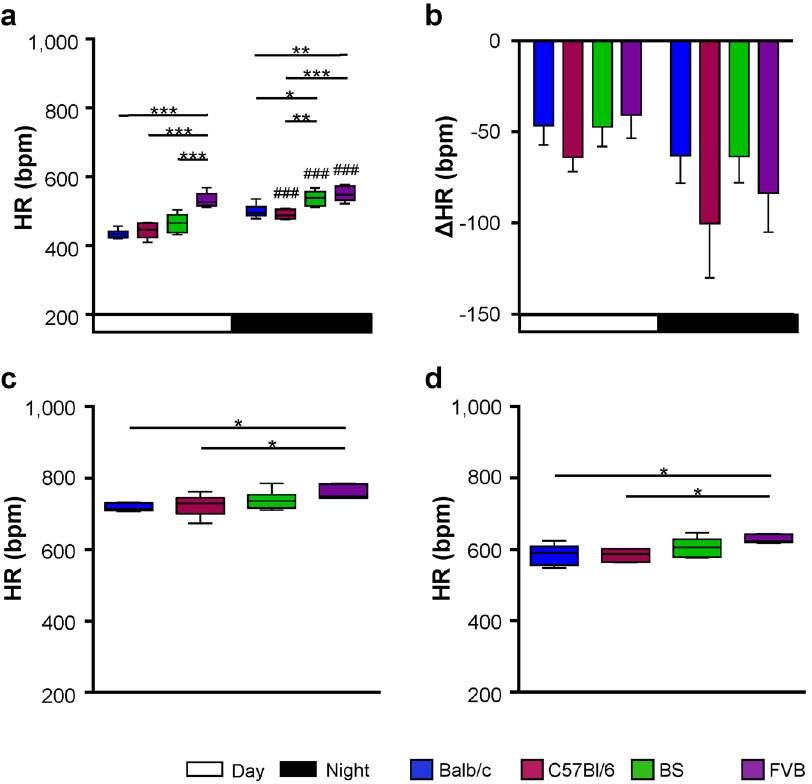
Figure 5. Heart rate under β -adrenergic modulation. ( a ) HRs under treatment with metoprolol during day- and night-time derived from 96 hours ECG recordings shown in Fig. 4. ( b ) HR reduction ( Δ HR) calculated as the difference between mean HRs under baseline conditions and under β -adrenergic blockade. ( c ) Maximal HRs and ( d ) mean HRs over 5 hours following isoproterenol injection. Day: 7AM-7PM, Night: 7PM-7AM. Data is given as median and 5–95 percentile ( a , c , d ) and as median and interquartile range ( b ). Balb/c n = 6, C57Bl/6 n = 6, BS n = 6, FVB n = 5. * p < 0.05; ** p < 0.01; *** p < 0.001 against another strain; ###p < 0.001 against